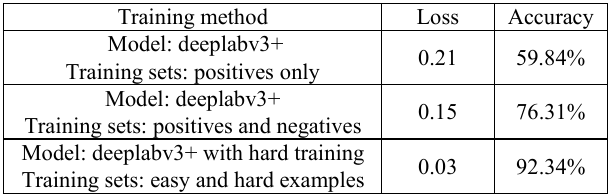
Table2. The improvement of loss and accuracy during